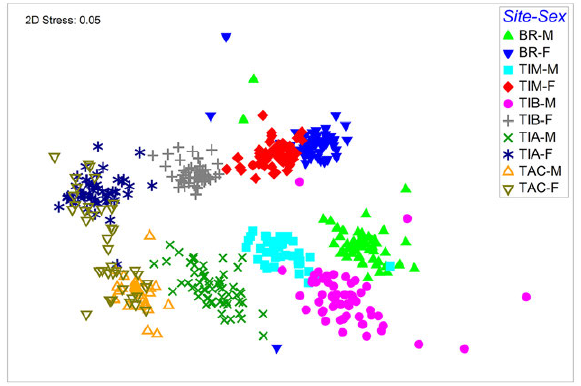
Fig. 3. – Non-metric multi-dimensional scaling (MDS) based on Euclidean distance, among defined groups by site-sex since stand- ardized morphometric variables of Aratus pisonii.